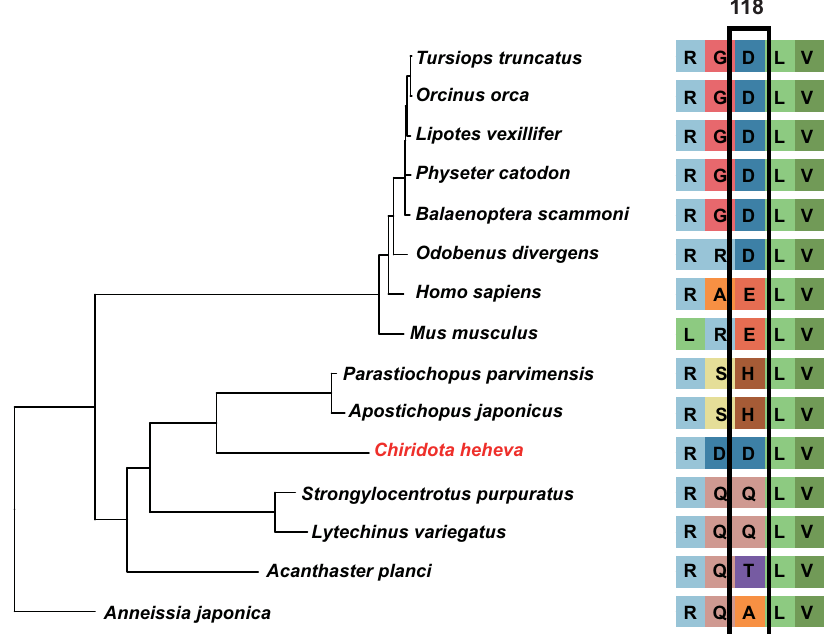
Fig. 6 A possible amino acid substitution of LHPP that contributed to hypoxic adaptation in C. heheva and cetaceans. The maximum-likelihood phylogenetic tree of cetaceans, C. heheva , and other echinoderms was reconstructed using 598 single-copy orthologs. C. heheva and cetaceans, which are tolerant to hypoxia, have the same amino acid substitution at position 118 of LHPP We applied a combination of homology-based and de novo predication methods to build consensus-gene models for the C. heheva genome assembly. For homology-based gene prediction, protein sequences of Helobdella robusta , Lytechinus variegatus , Strongylocentrotus purpuratus , Dimorphilus gyrociliatus , Apostichopus japonicus and Acanthaster planci were aligned to the C. heheva genome assembly using tblastn. The exon – intron structures then were determined according to the alignment results using GenomeThreader (v1.7.0) 76 . In addition, de novo gene prediction was performed using Augustus (v3.3.2) 77 , with the parameters obtained by training the software with protein sequences of Drosophila melanogaster and Parasteatoda tepidariorum . Two sets of gene models were integrated into a nonredundant consensus-gene set using EvidenceModeler (v1.1.1) 78 . To identify functions of the predicted proteins, we aligned the C. heheva protein models against NCBI NR, trEMBL, and SwissProt database using blastp (E- value threshold: 10 − 5 ), and against eggNOG database 79 using eggNOG-Mapper 80 . In addition, KEGG annotation of the protein models was performed using GhostKOALA 81 .